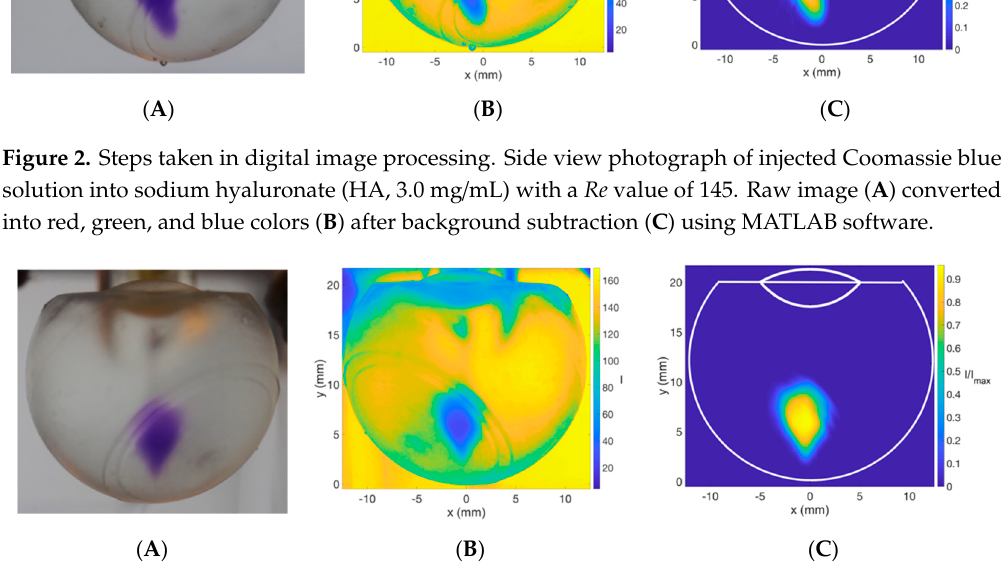
Figure 3. Steps taken in digital image processing. Front view photograph of injected Coomassie blue solution into sodium hyaluronate (HA, 1.0 mg/mL) with a Re value of 156. Raw Image ( A ) converted into red, green, and blue colors ( B ) after background subtraction ( C ) using MATLAB software.